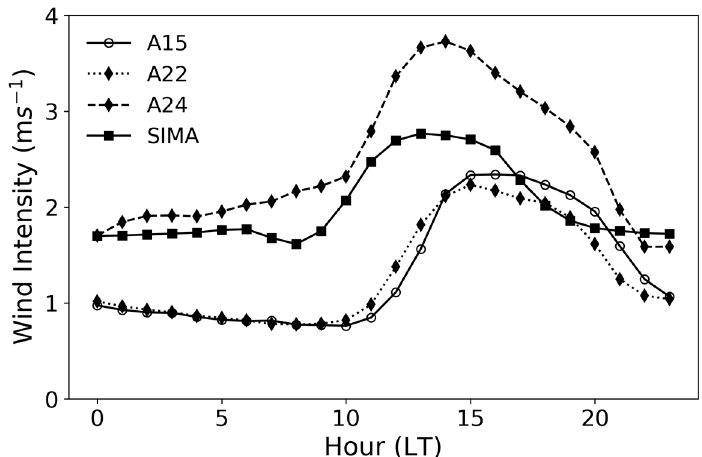
Figure A1. Daily cycle of mean hourly wind speed at three sites nearby reservoir (A15, A22, and A24) and inside the reservoir (SIMA) calculated over the whole period shown in Table 2.